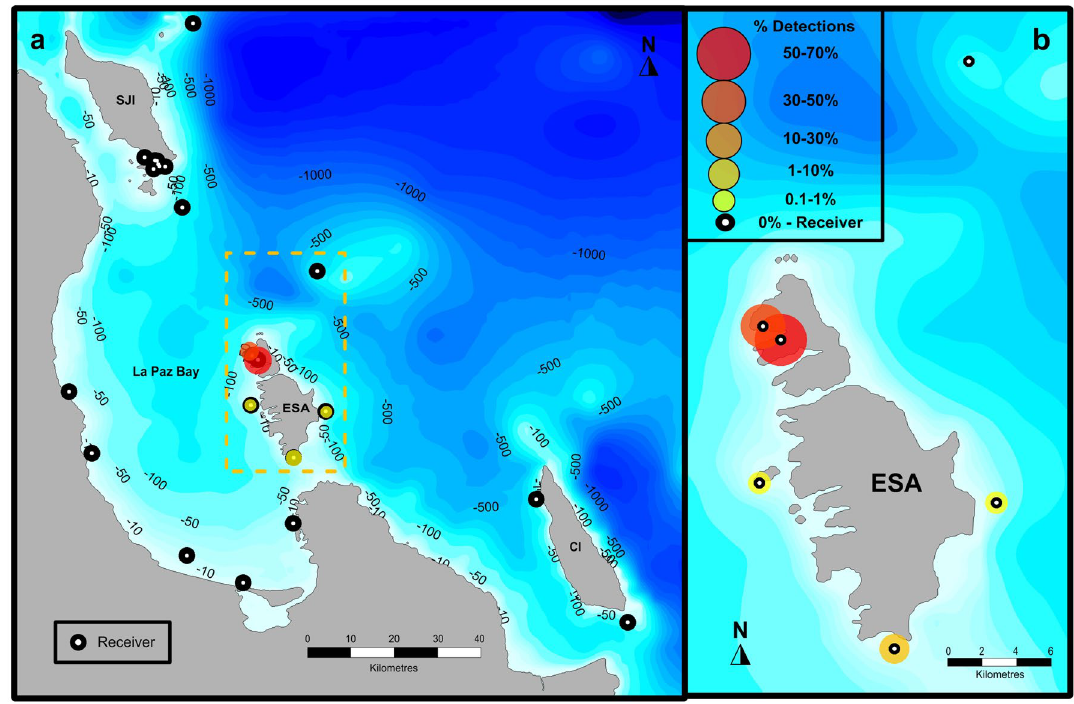
Figure 3. ( a ) Mobula munkiana detection map between August 2017 and May 2019 at La Paz Bay and the surrounding islands of San Jose (SJI), Cerralvo (CI), and ( b ) the Espiritu Santo Archipelago (ESA). The proportion (%) is indicated by circle size and color for each receiver described in the